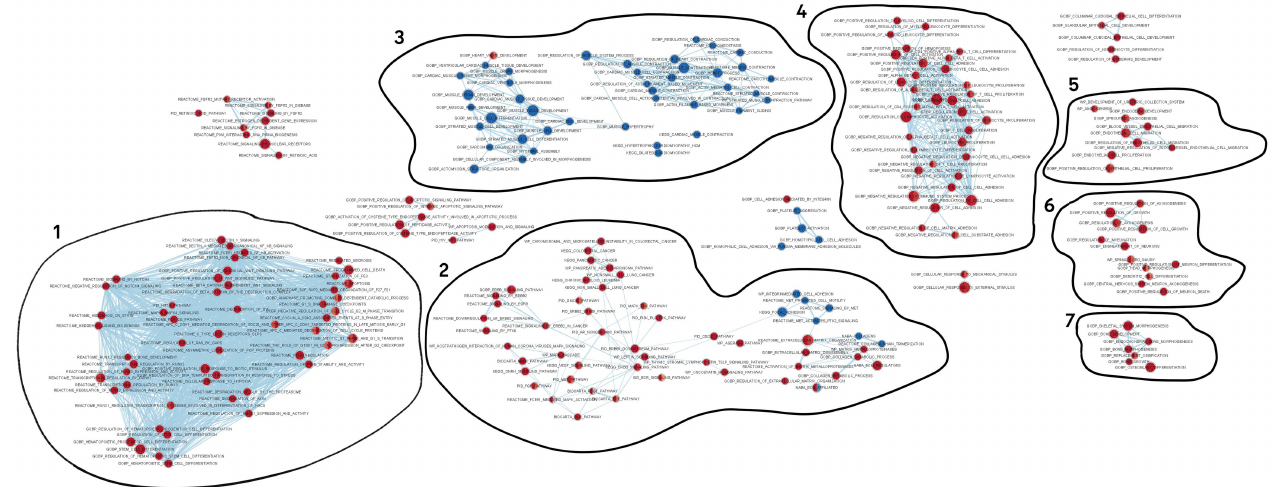
Figure 8. Network of enrichment biological processes and pathways during ambulacrum regeneration in E. fraudatrix . Nodes represent biological process (gene set). Edges represent overlap between pair of gene sets. Node size and edge width depend on the number of genes. Node fill represents enrichment scores of terms at the first (right half) and second (left half) stage of regeneration relative to the intact sample. The color gradient represents an increase (red) or decrease (blue) in the level of expression (depending on the enrichment score) in the regeneration, relative to the intact